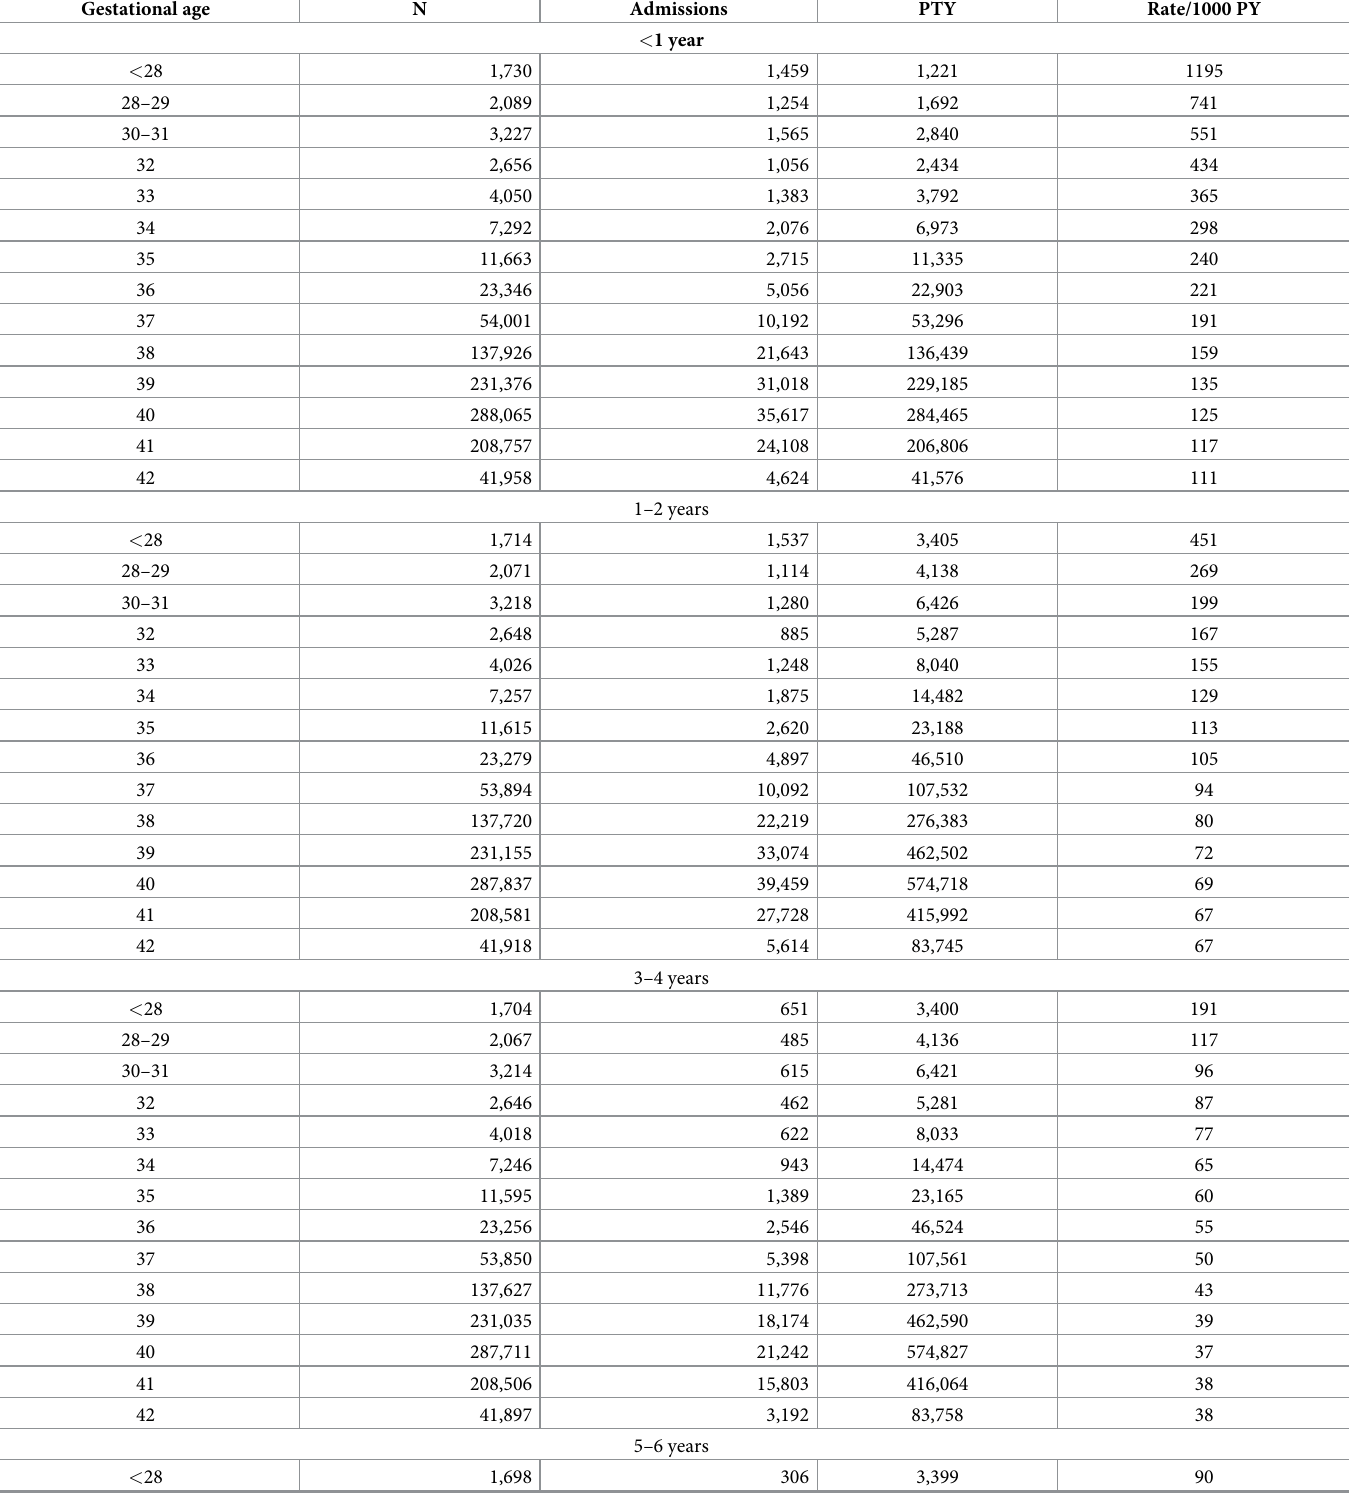
Table 2. Crude infection-related hospital admission rates by gestational age and age at